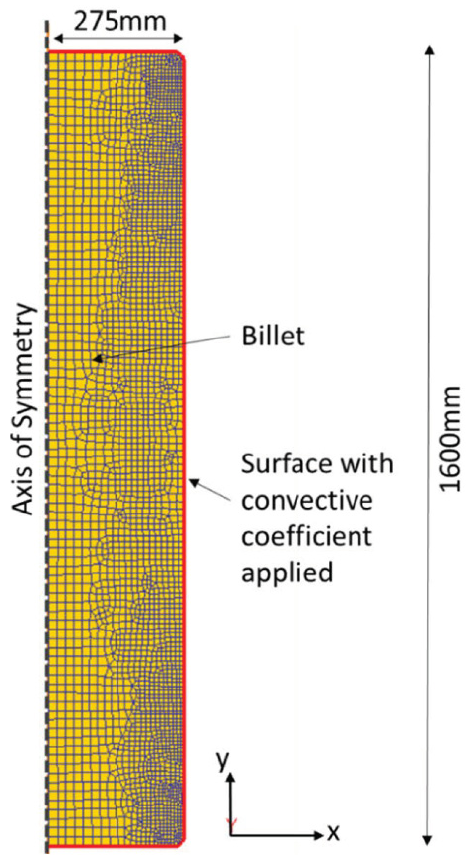
Figure 2. Finite element modelling setup.